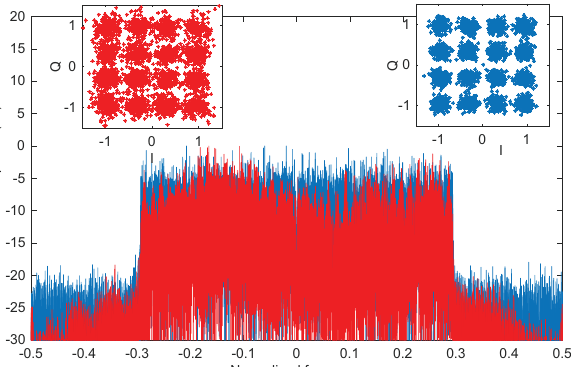
Figure 11. Data transmission results. The baseband spectrum and 16–QAM constellation, and red color for a LOS link of 0.6 m with background reflections. Blue color is the corresponding simulation result.